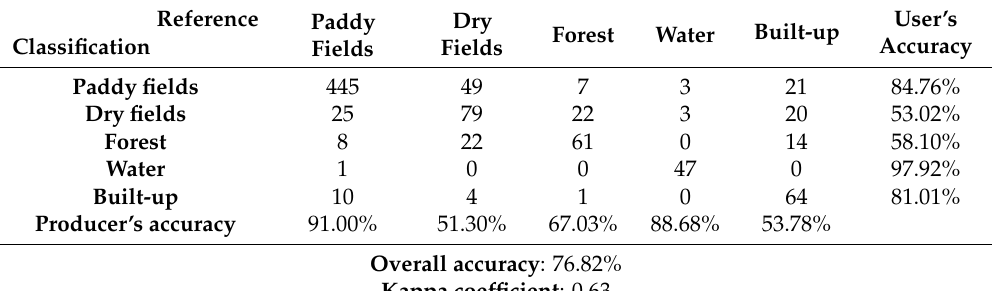
Table 5. Confusion matrix and accuracy statistics for classification using fusion of all